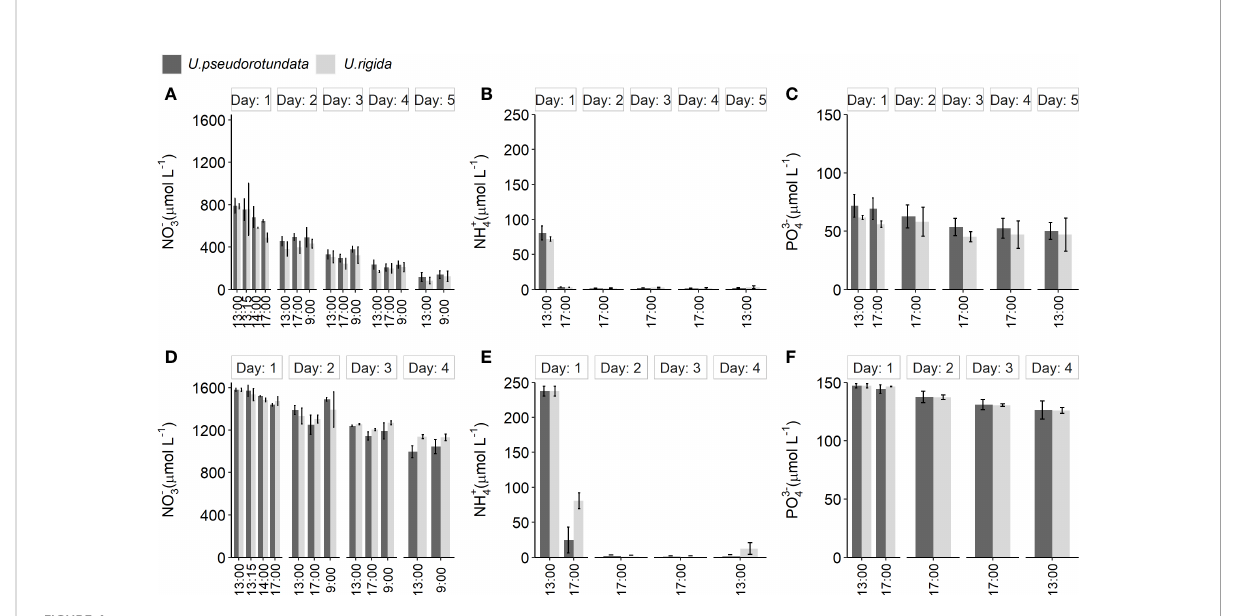
FIGURE 4 Changes in concentrations of NO 3- , NH 4+ , and PO 43- (µmol L -1 ) during the experimental cultivation of U. pseudorotundata and U. rigida. (A – C) refer to experiment 1, conducted during 5 days with 50% fi sh ef fl uent. (D – F) refer to experiment 2, conducted during 4 days with 100% fi sh ef fl uent. Values are mean ± SD, n = 3.